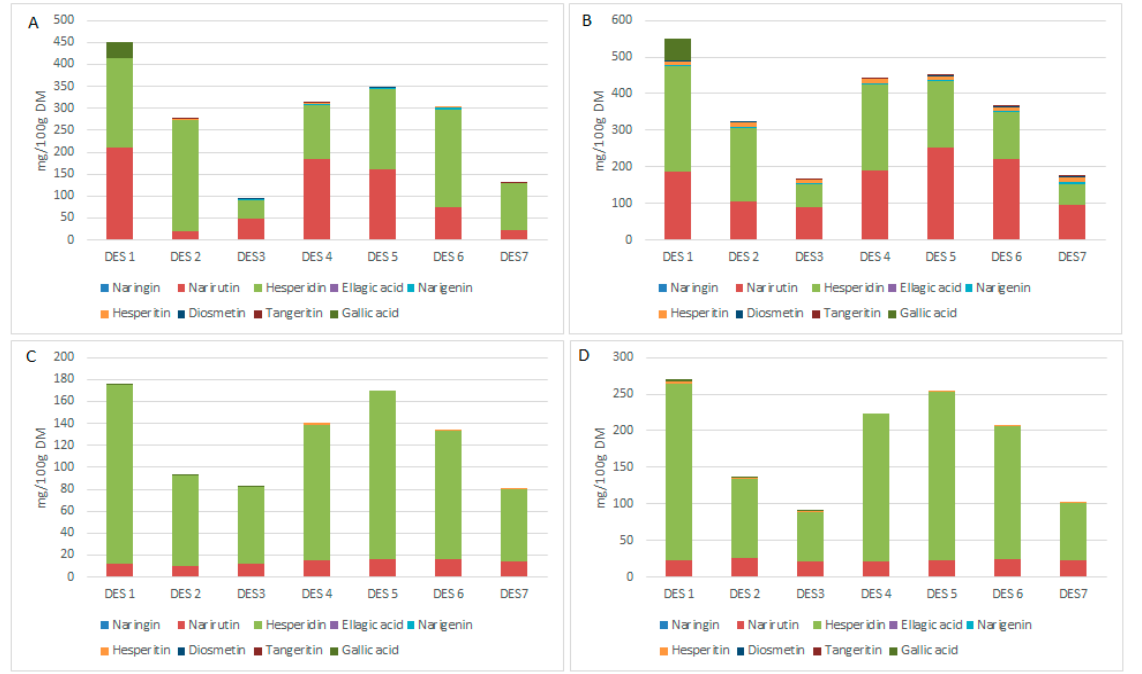
Figure 2. Individual phenolic compounds extracted from CWWP at 40 and 60 °C ( A , B ); Individual phenolic compounds extracted from CWNP at 40 and 60 °C ( C,D ).